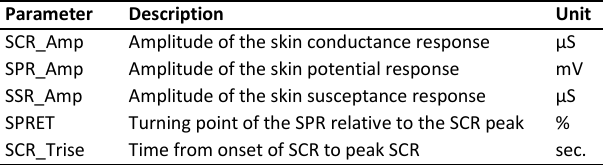
Table 1: Overview of extracted parameters from the EDA responses that were used in the data